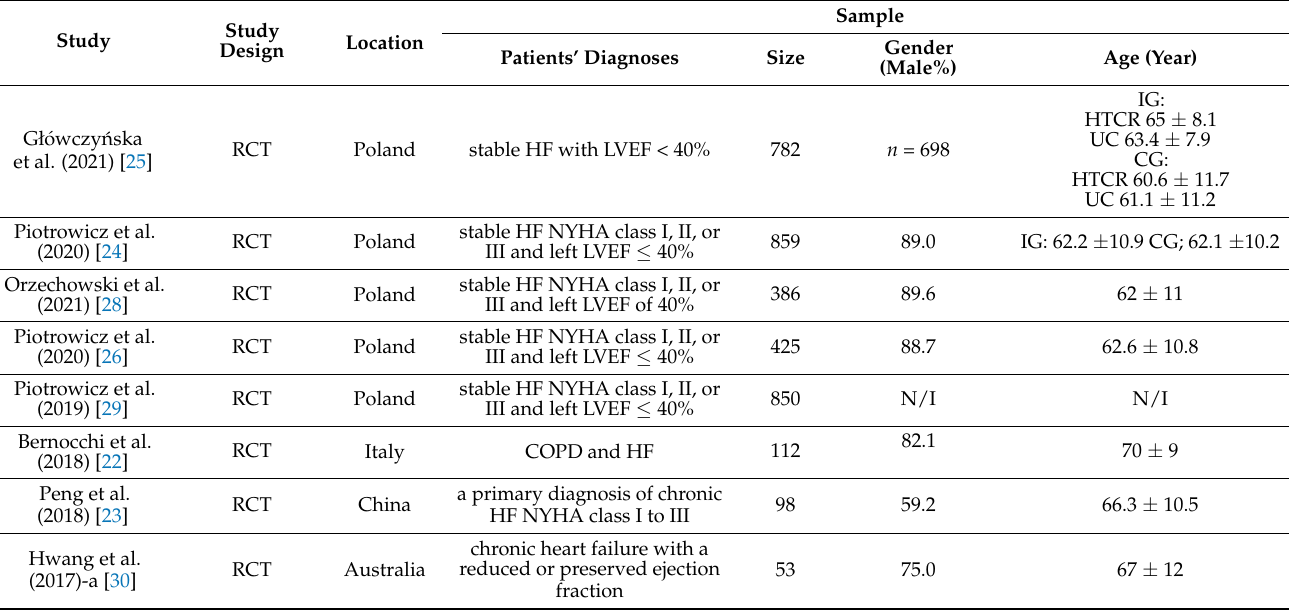
Table 1. Characteristics of included